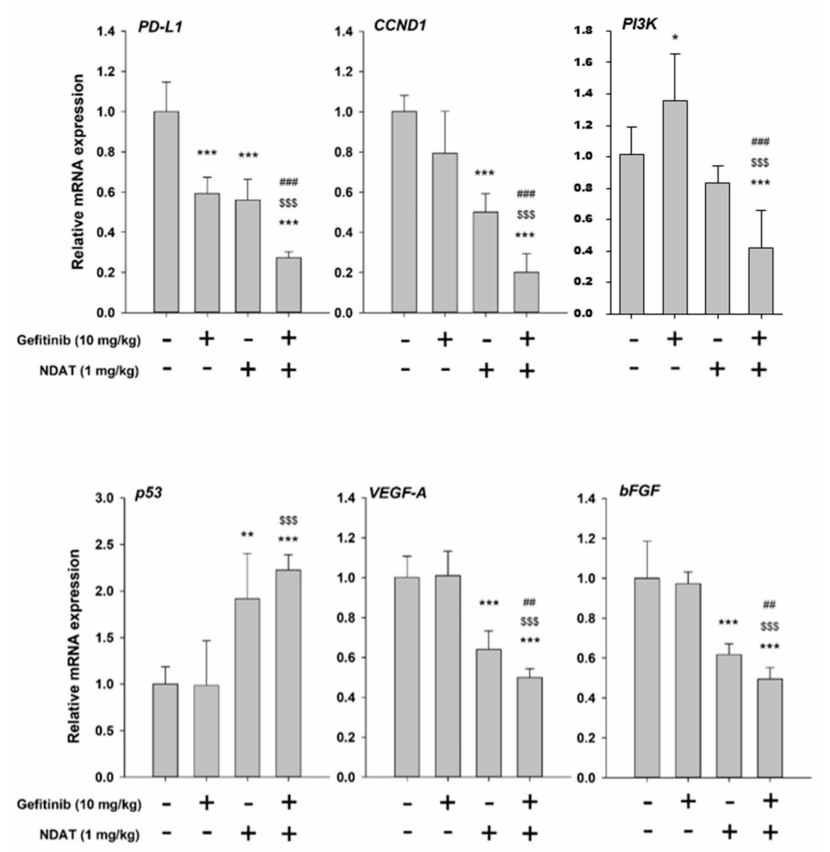
Figure 7. NDAT enhances gefitinib-regulated gene expression in HCT116 cell-derived xenograft tumor tissues. Tumor tissues were homogenized, and total RNA was extracted. Total RNA was then transcribed into cDNA. The expression levels of CCND1, p53, VEGF-A, PD-L1, EGFR , and bEGF (EGF2) were examined with qPCR experiments. The number of independent experiments N = 4. Data are expressed as mean ± SD; * p < 0.05, ** p < 0.01, *** p < 0.001, compared with untreated controls;